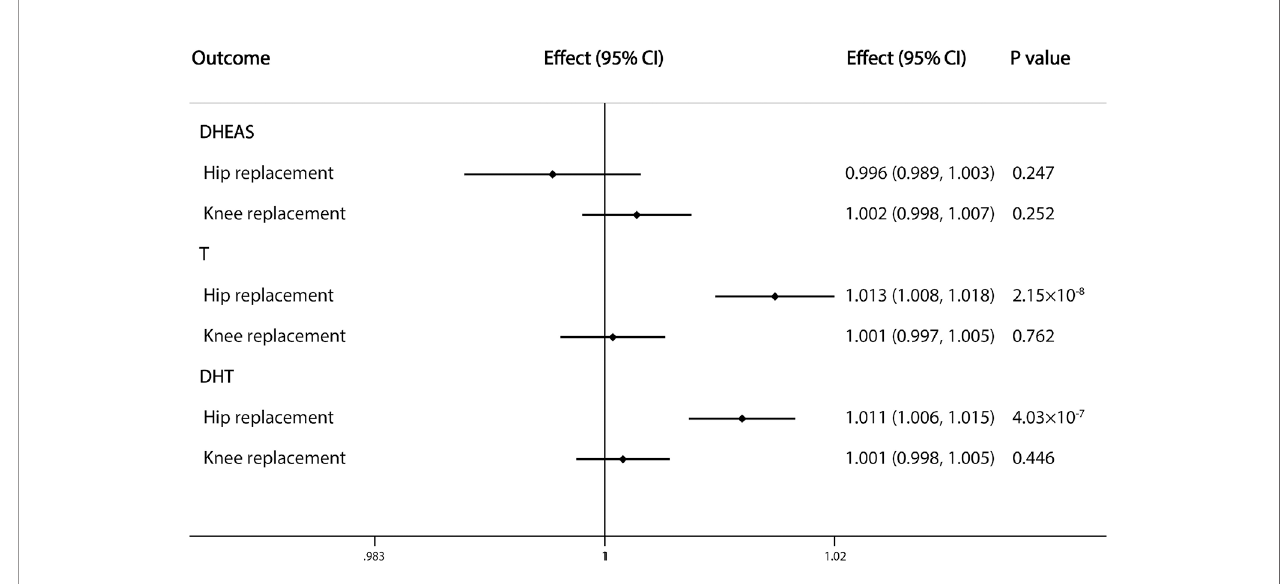
FIGURE 4 | Causal effects of sex steroids on the risk of joint replacement of hip and knee. The estimated effects, 95% con fi dence intervals and p-values of associations were contained. Effect, the combined causal effect; CI, con fi dence interval; P value, p-value of the causal